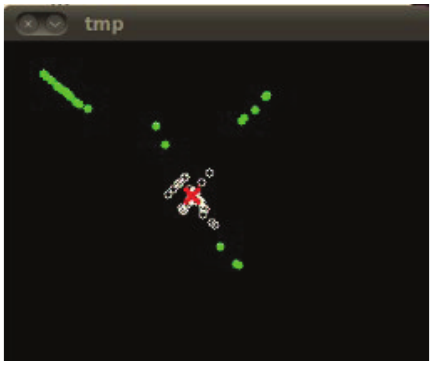
Figure 7: Clustering processing of VPFE algorithm. Figure 8: Collected image of the indoor